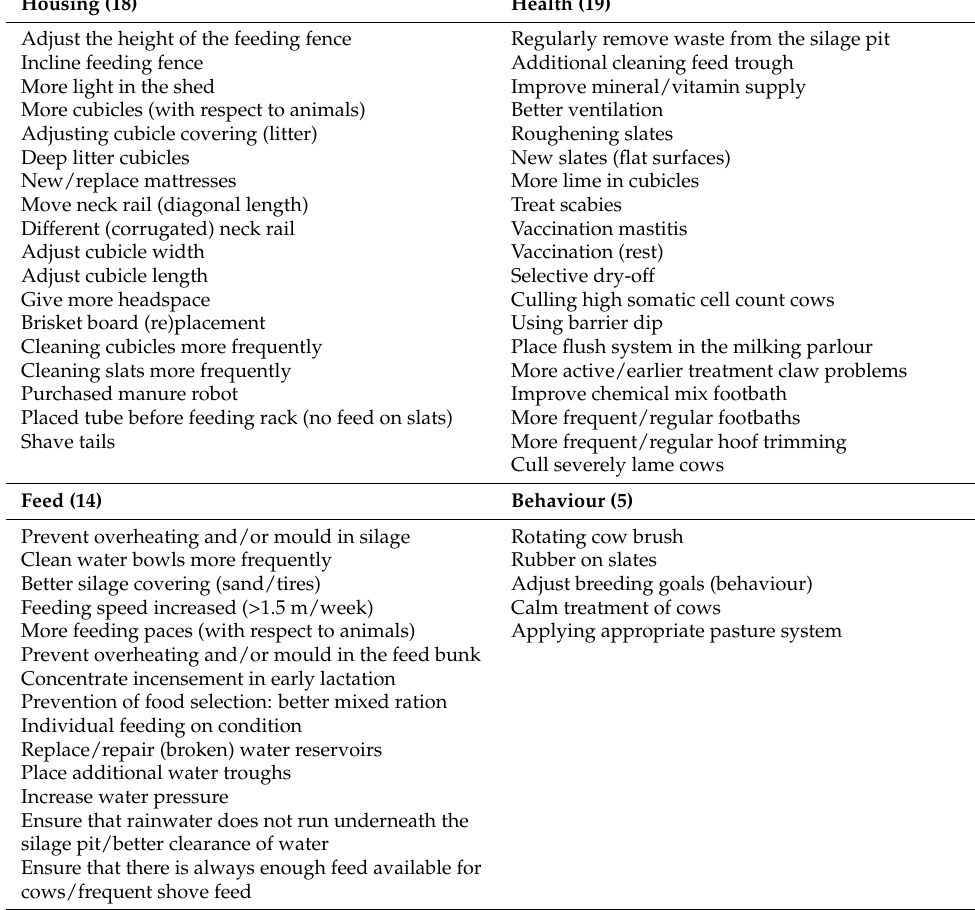
Table 8. Recommendations made to the farmers.